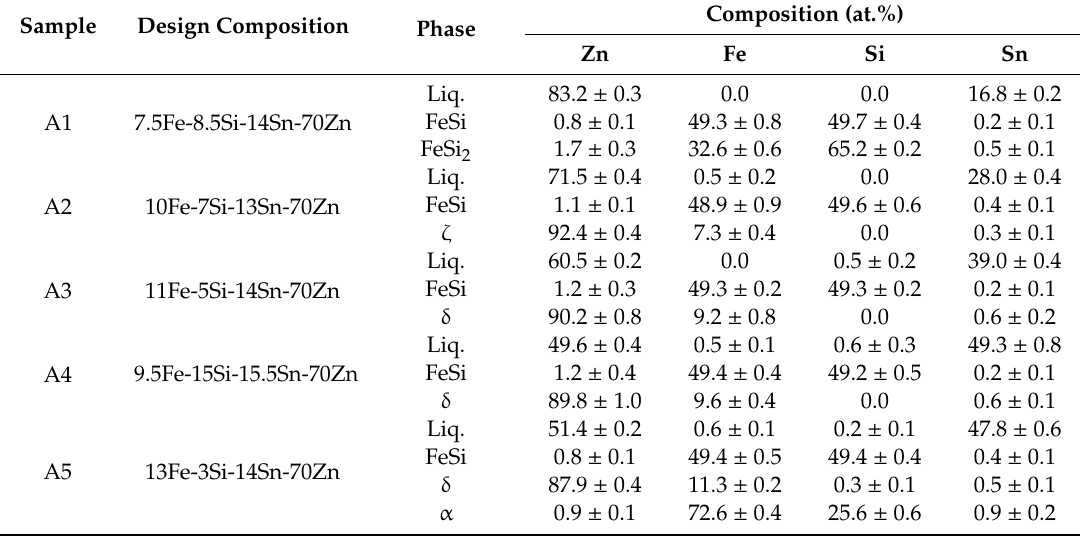
Table 2. Composition of samples and phases in the 450 ◦ C isothermal section of the Fe-Si-Sn-Zn quaternary system with Zn fixed at 70